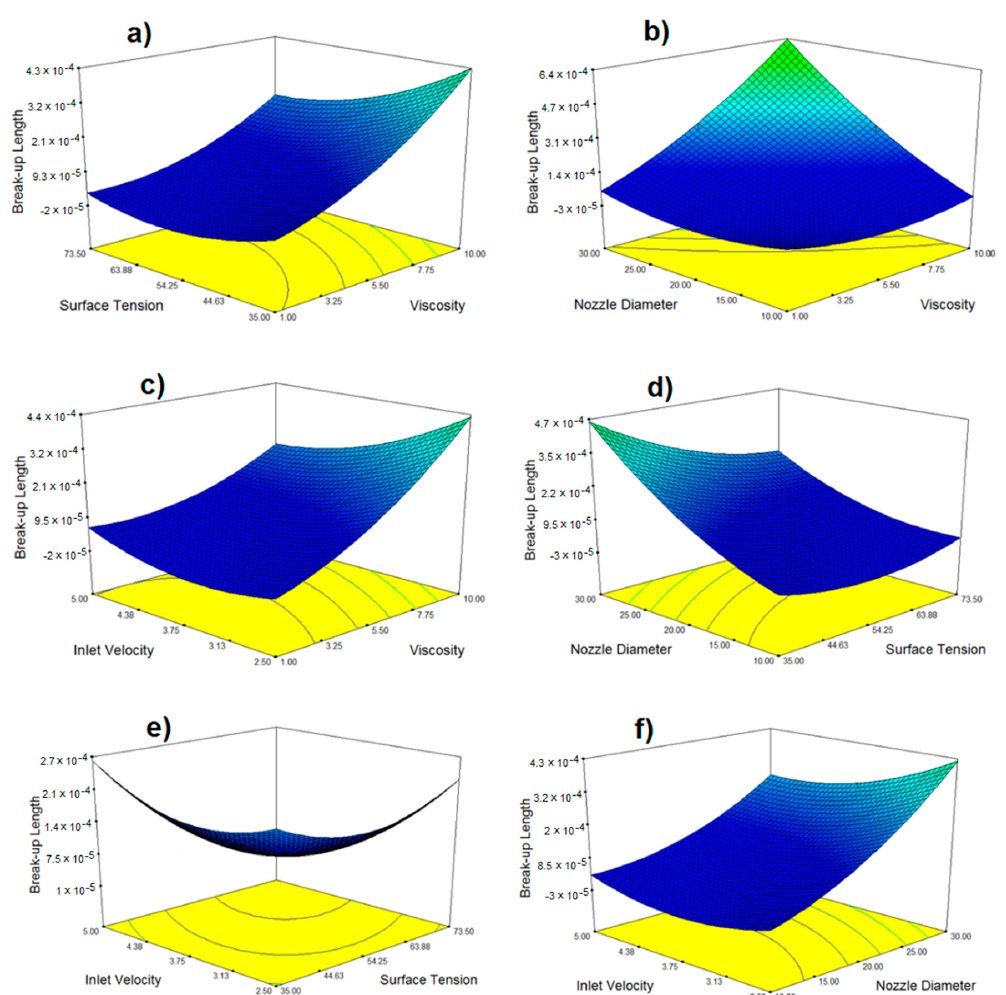
Figure 9. Contour response plots for break-up length as a function of ( a ) surface tension and viscosity, ( b ) nozzle diameter and viscosity, ( c ) inlet velocity and viscosity, ( d ) nozzle diameter and surface tension, ( e ) inlet velocity and surface tension, and ( f ) inlet velocity and nozzle diameter.